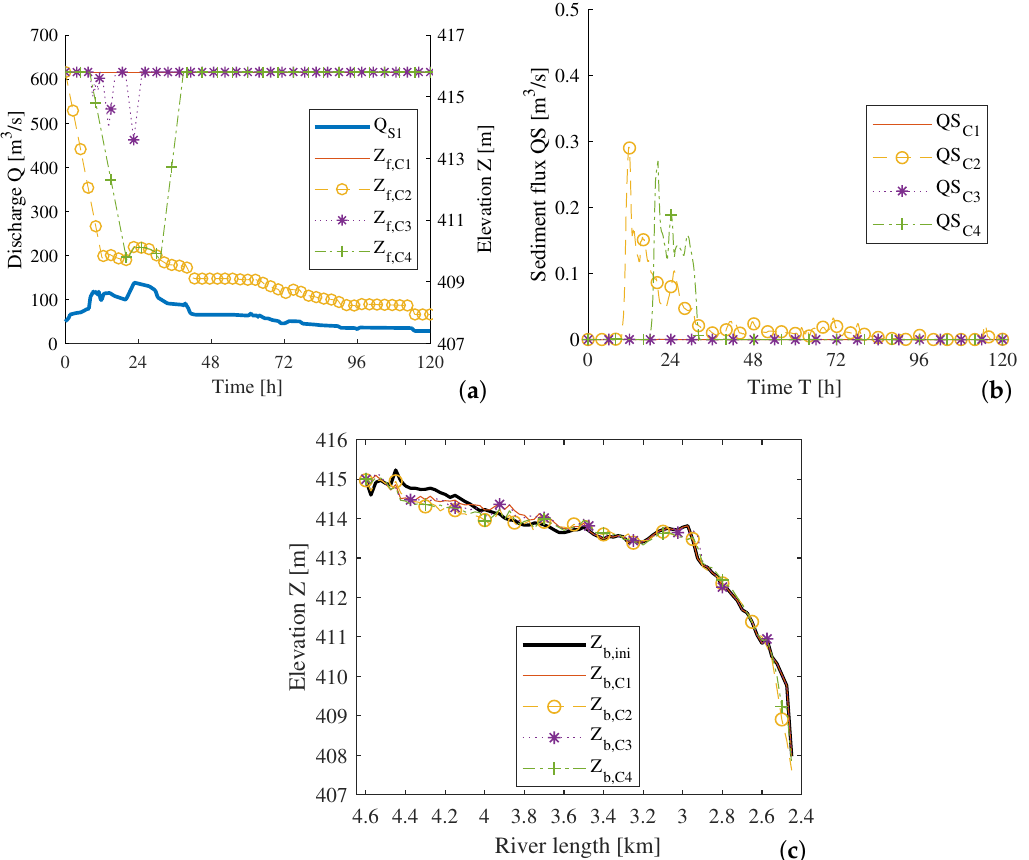
Figure 8. Normal flow scenario: ( a ) boundary conditions for the normal flow discharge and the water surface level of the four cases; ( b ) simulated sediment flux at the outlet boundary for each case; and ( c ) longitudinal section of the mean riverbed in the reservoir for initial conditions (black) and the final situation for each